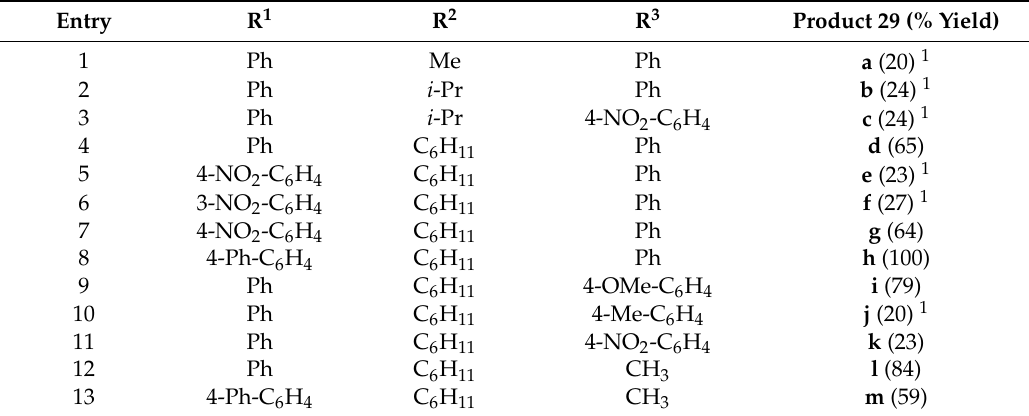
Table 3. Cycloaddition of the azomethine ylides derived from aziridines 23 to diphenylcyclopropenone ( 3a ) (Scheme